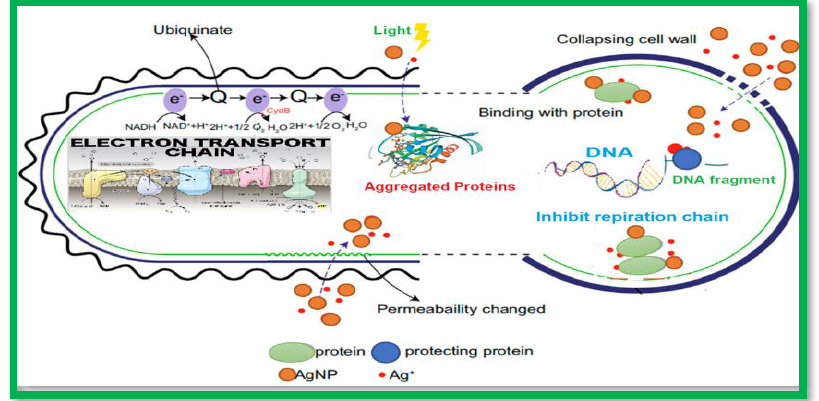
Figure 1. Silver nanoparticles ’ (AgNPs) antibacterial mechanism.